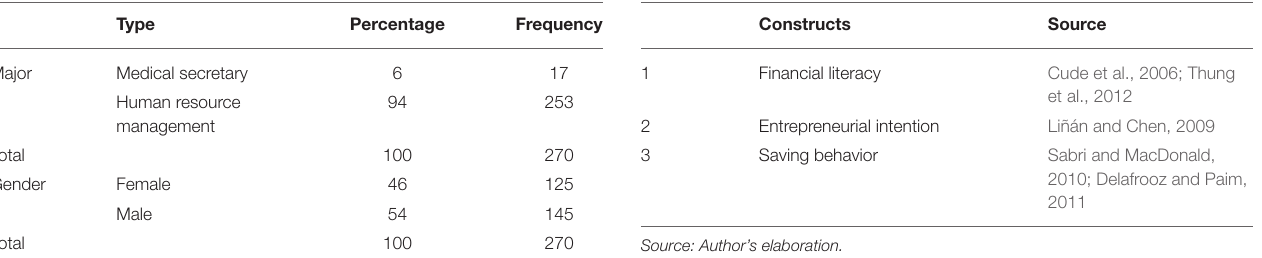
TABLE 1 | Respondents’ demographic information. TABLE 2 | Sources for the study